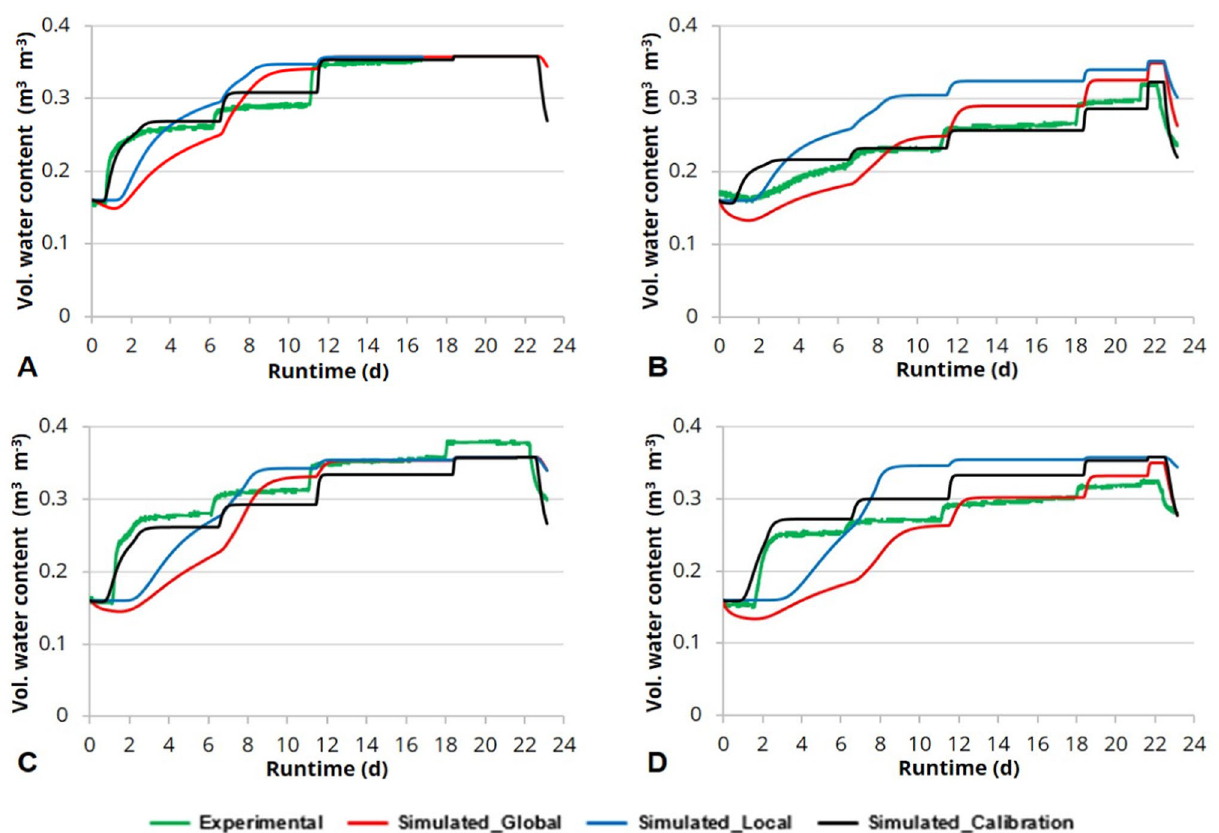
Fig. 4 Observed (green) and simulated water content for soil 2 at the observation points H1 ( A ), H3 ( B ), H4 ( C ) and H6 ( D ) by using basic hydraulic soil parameters originating from local (blue) and global (red) measurement as well as after calibration process (black)